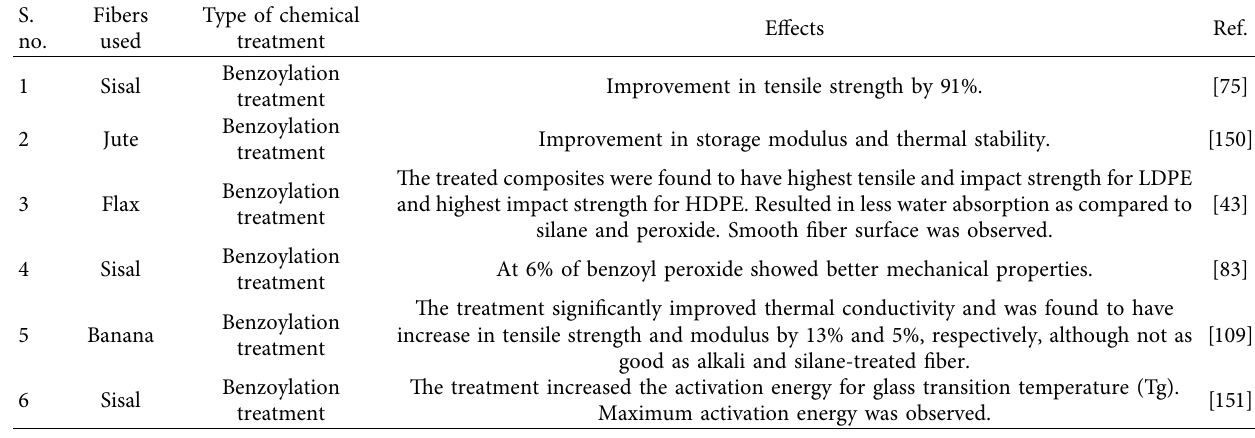
Table 6: Effect of benzoylation treatment on various biofibers.